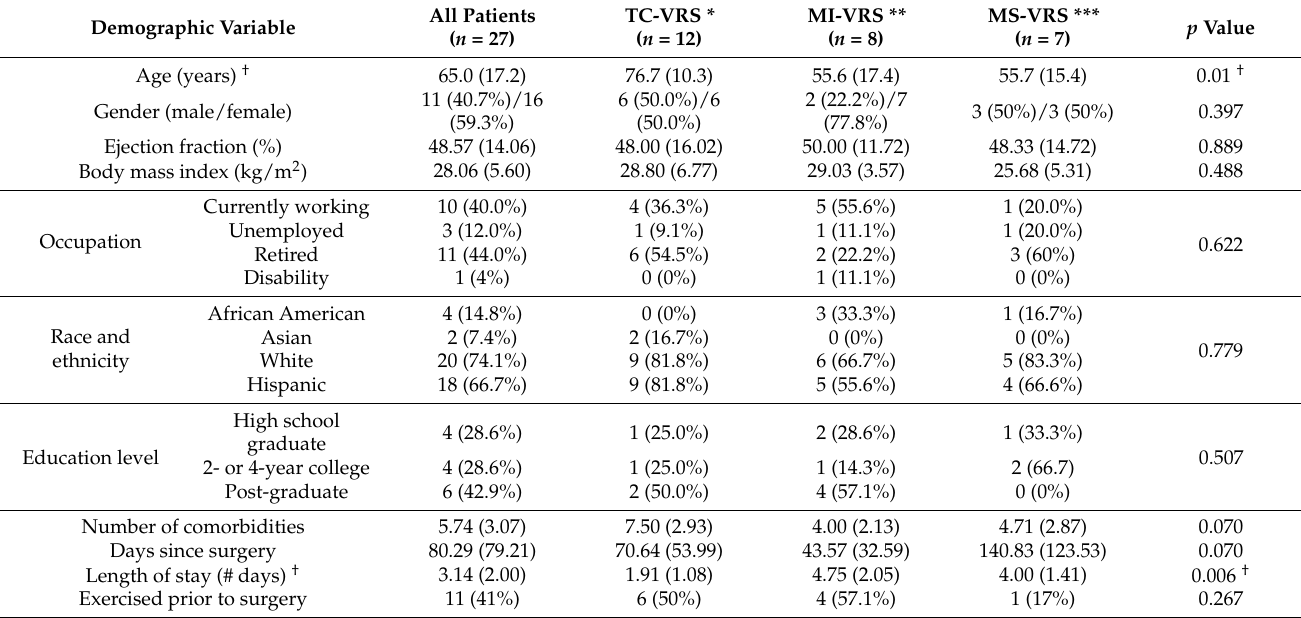
Table 1. Demographic variables: mean (SD) or n